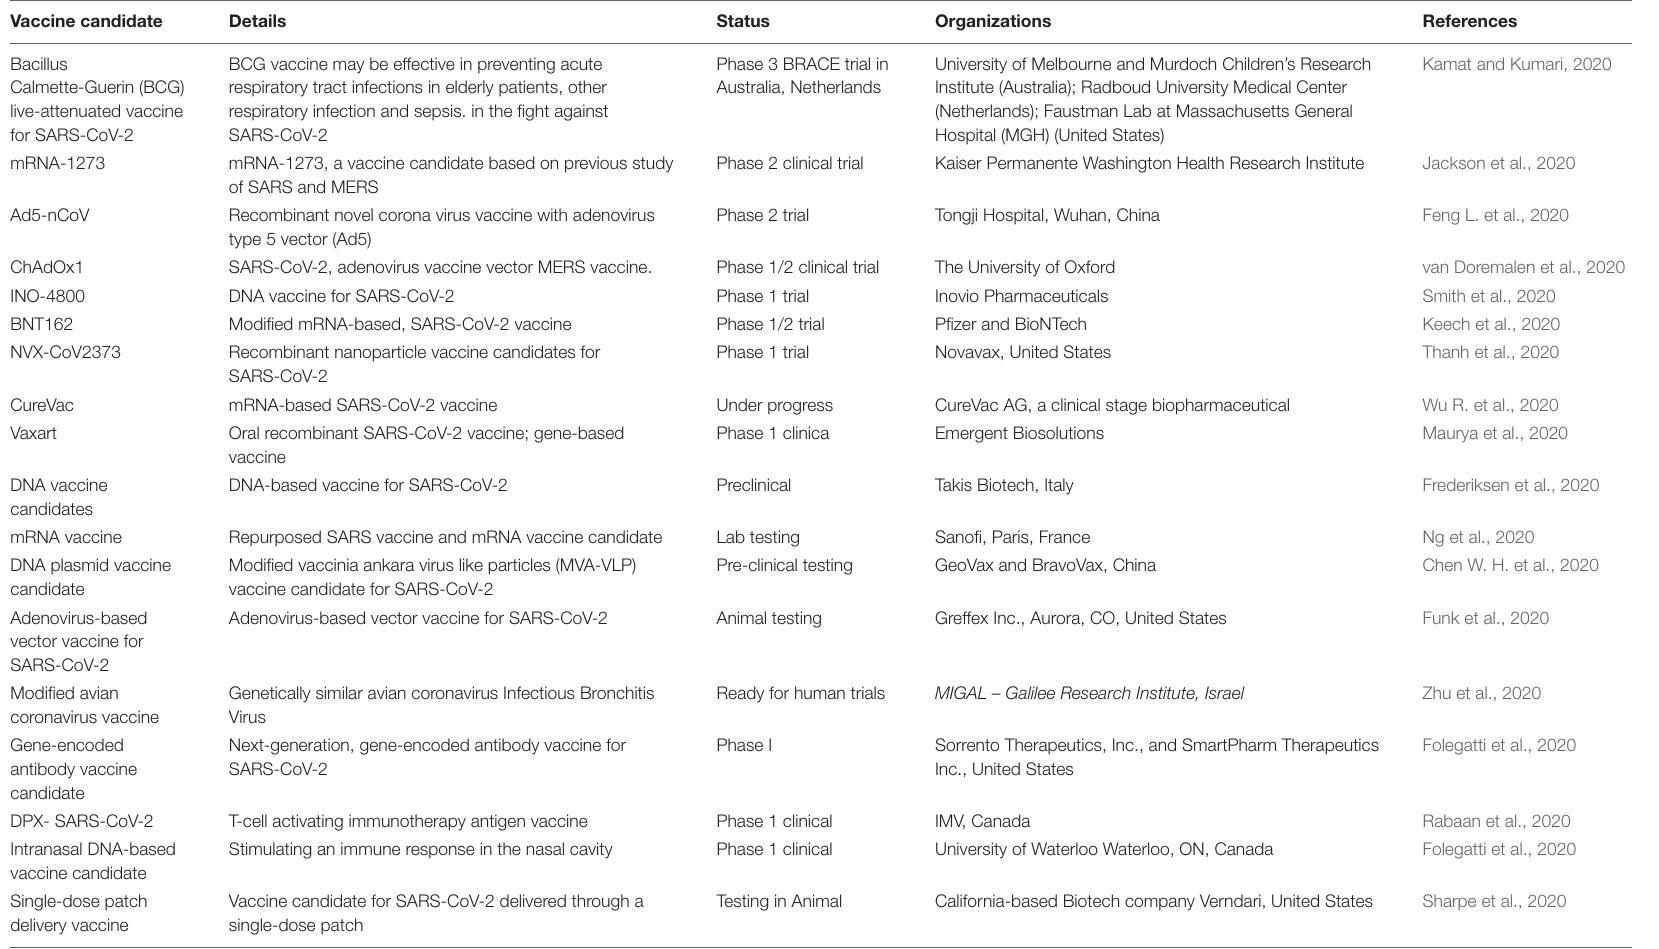
TABLE 4 | Tabular representation of ongoing clinical studies of vaccines for